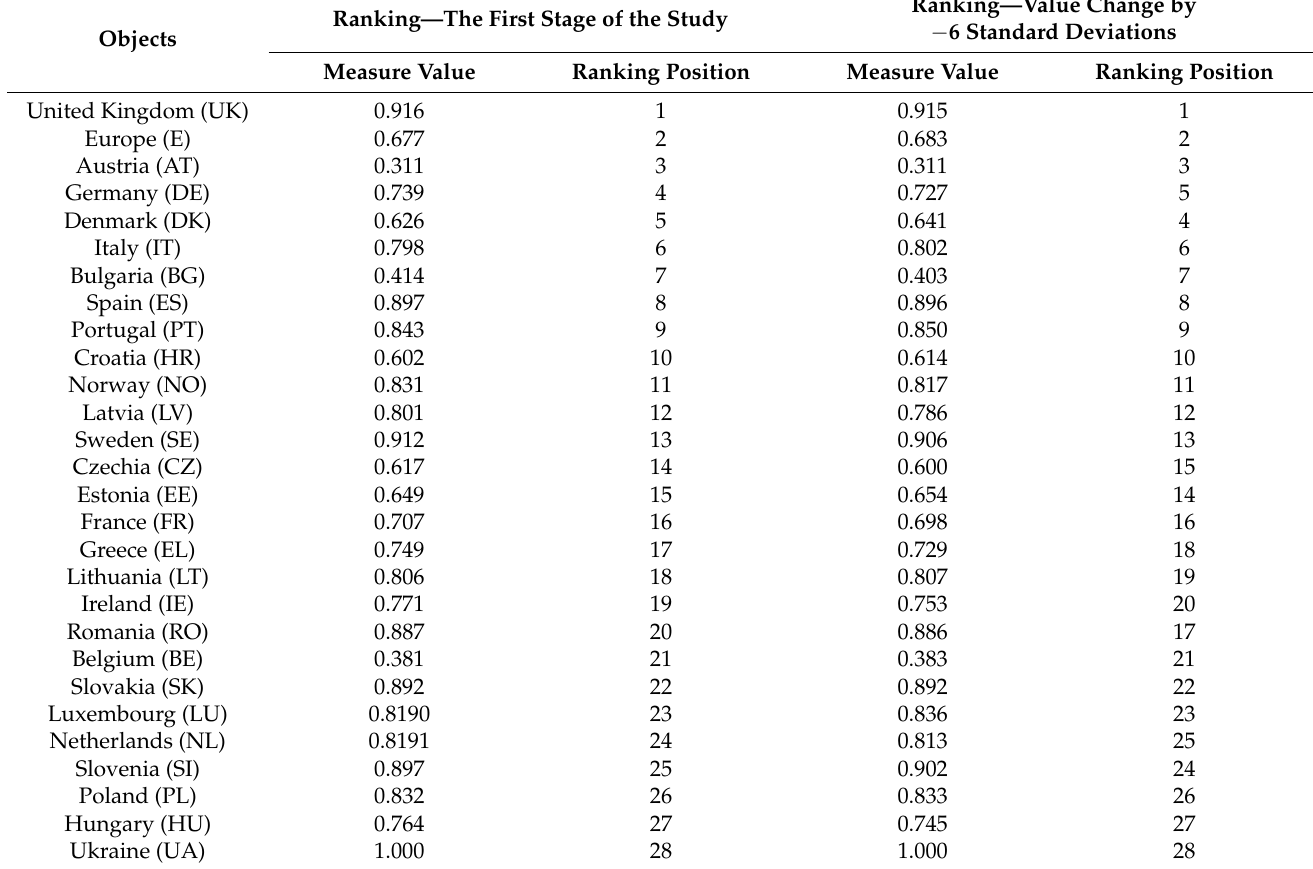
Table 2. Ranking of objects for VIKOR method after changing value by − 6 standard